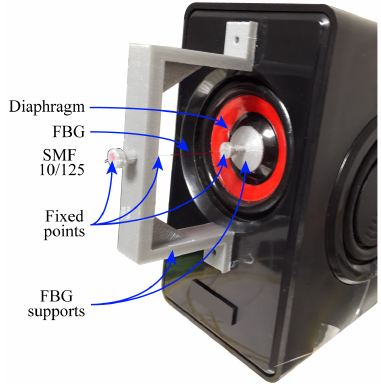
Figure 4. A low-cost acousto-optical modulator (AOM) implementation with a FBG connected to a